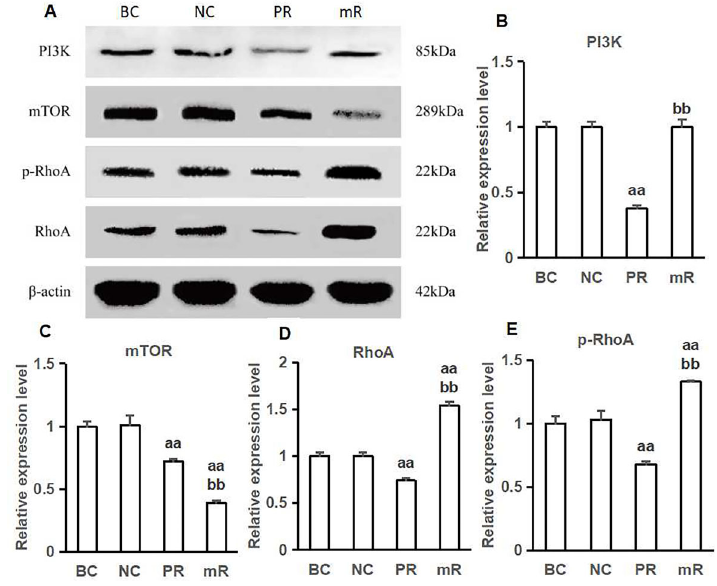
Figure 2. Expression of PI3K, mTOR, RhoA, and p-RhoA proteins in each group. A , Western blot test for the expression of PI3K, mTOR, RhoA, and p-RhoA proteins. B – E , Expression levels of PI3K, mTOR, RhoA, and p-RhoA proteins in each group respectively. aa P o 0.01, compared with the blank control group (BC) and the negative control group (NC); bb P o 0.01, compared with the PI3K-RNAi group (PR) (ANOVA and LSD t -test). mR: mTOR-RNAi group.